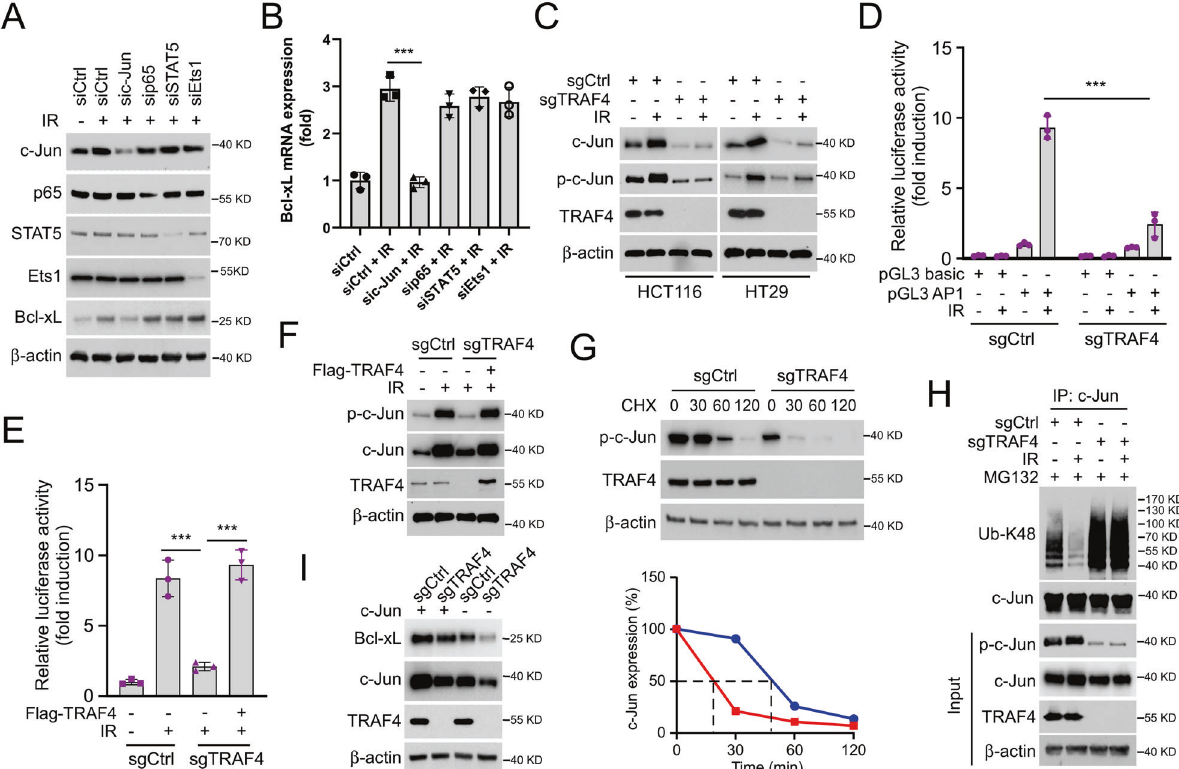
Fig. 4 c-Jun is required for IR-induced Bcl-xL expression. A and B HT29 cells were transfected with sic-Jun, sip65, siSTAT5 and siEst1 for 24 h, followed by IR (4 Gy) treatment and cultured for 4 h. IB was used to examine the protein expression ( A ); the mRNA levels of Bcl-xL was examined by RT-qPCR (B). *** p < 0.001. C TRAF4-null HCT116 and -HT29 cells were treated with or without IR (4 Gy) and cultured for 30 min. IB was used to examine the protein expression. D TRAF4-null HT29 cells were transfected with pGL3 basic or pGL3 AP1 for 48 h and treated